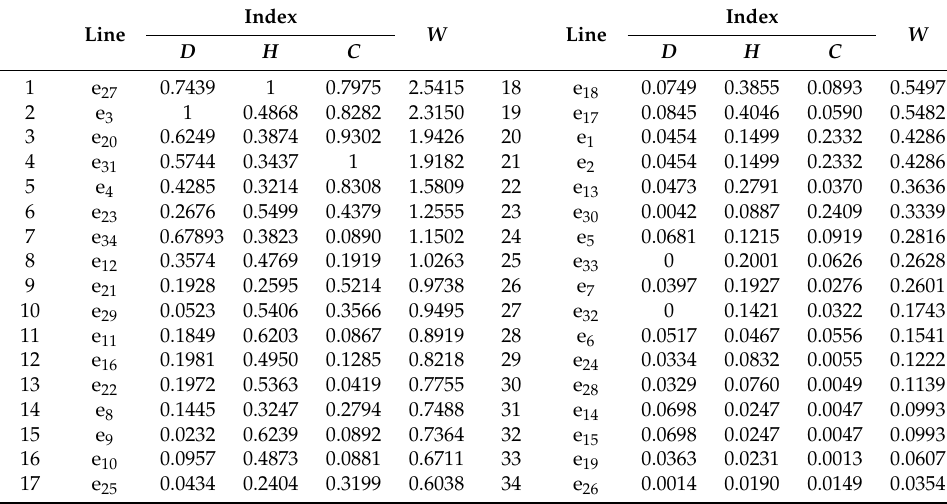
Table 3. Calculation result of transmission